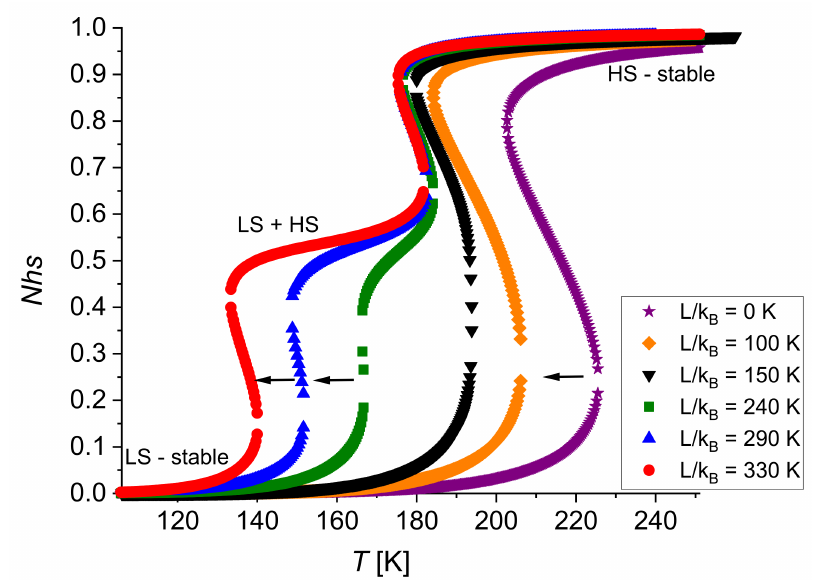
Figure 5. Simulated thermal evolution of the HS fraction Nhs for different values of the L / k B parameter in a 6 × 6 2D SCO nanoparticle. Purple stars: L / k B = 0 K; Orange diamonds: L / k B =100 K; Black down triangles: L/k B = 150 K; Green squares: L / k B = 240 K; Blue up triangles: L / k B = 290 K; Red circles: L / k B = 330 K. The parameters used in the calculations are: ∆ / k B = 1300 K, G / k B = 172 K, J bb / k B = 60 K, J ss / k B = 50 K, J bs / k B = 20 K and ln( g ) =